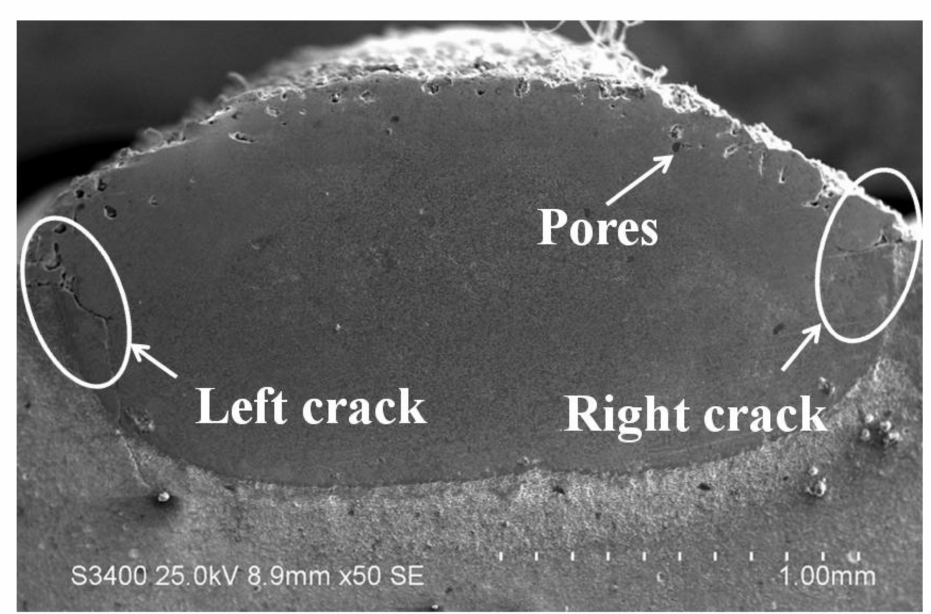
Figure 12. Crack location of cladding layer cross